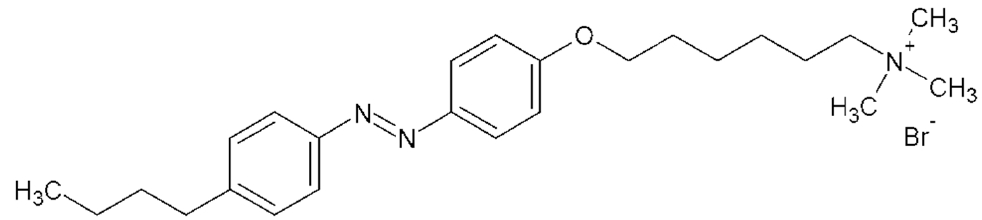
Figure 1. AzoTAB structure in trans-conformation.